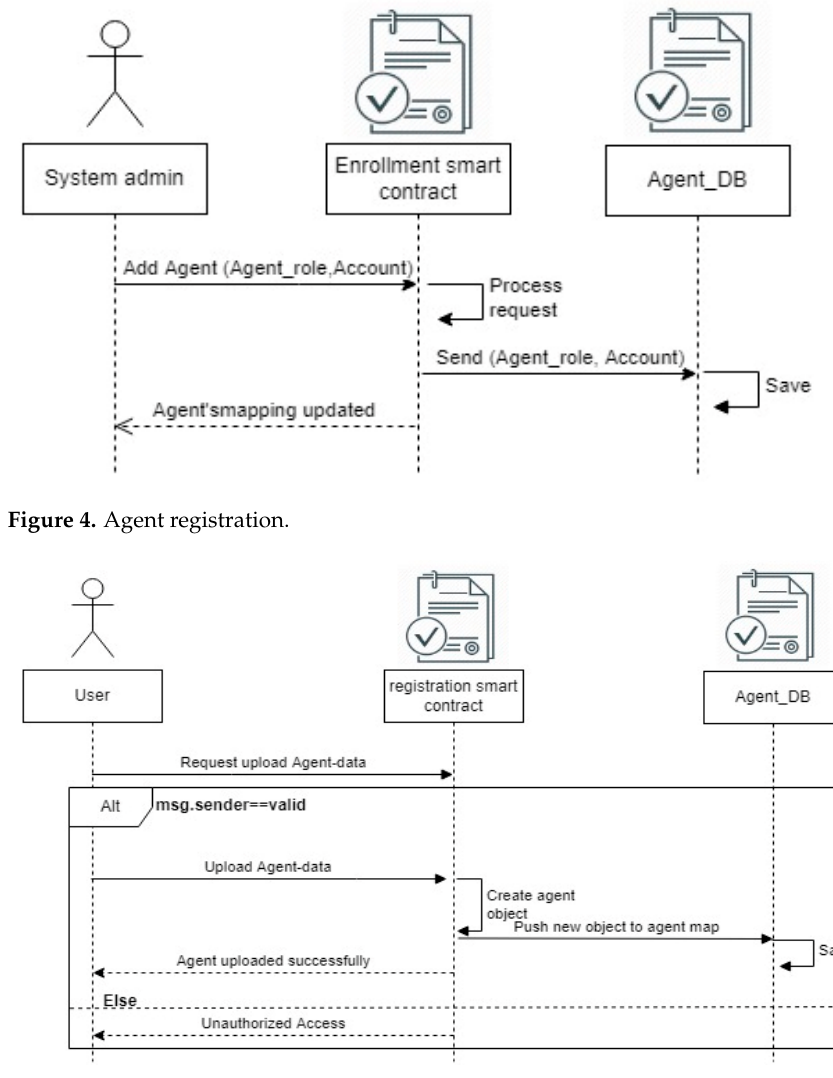
Figure 5. Agent enrollment.